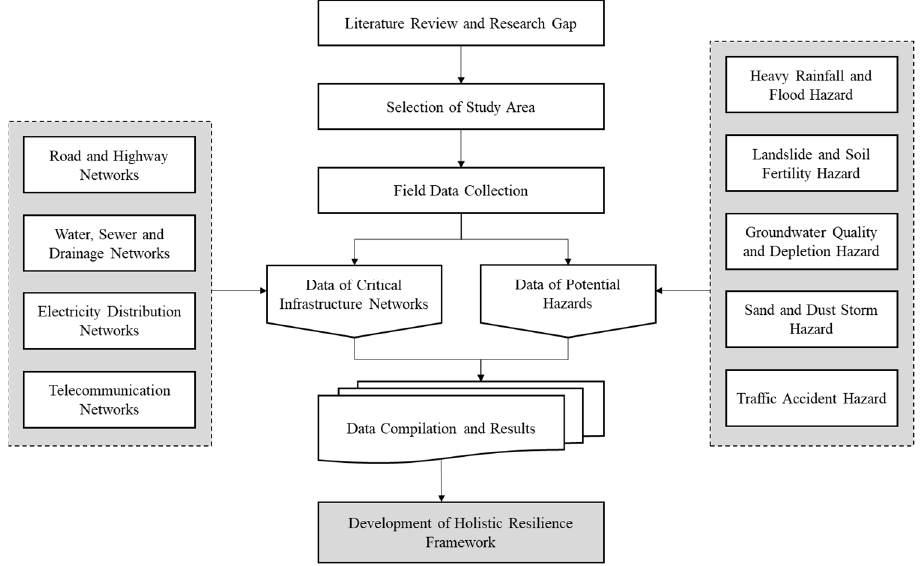
Figure 2. Methodology followed for the research.